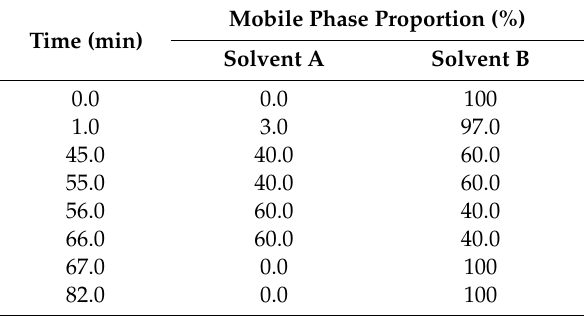
Table 1. Mobile phase gradient for the analytical High-Performance Liquid Chromatography (HPLC). Mobile Phase Proportion (%) Time (min)